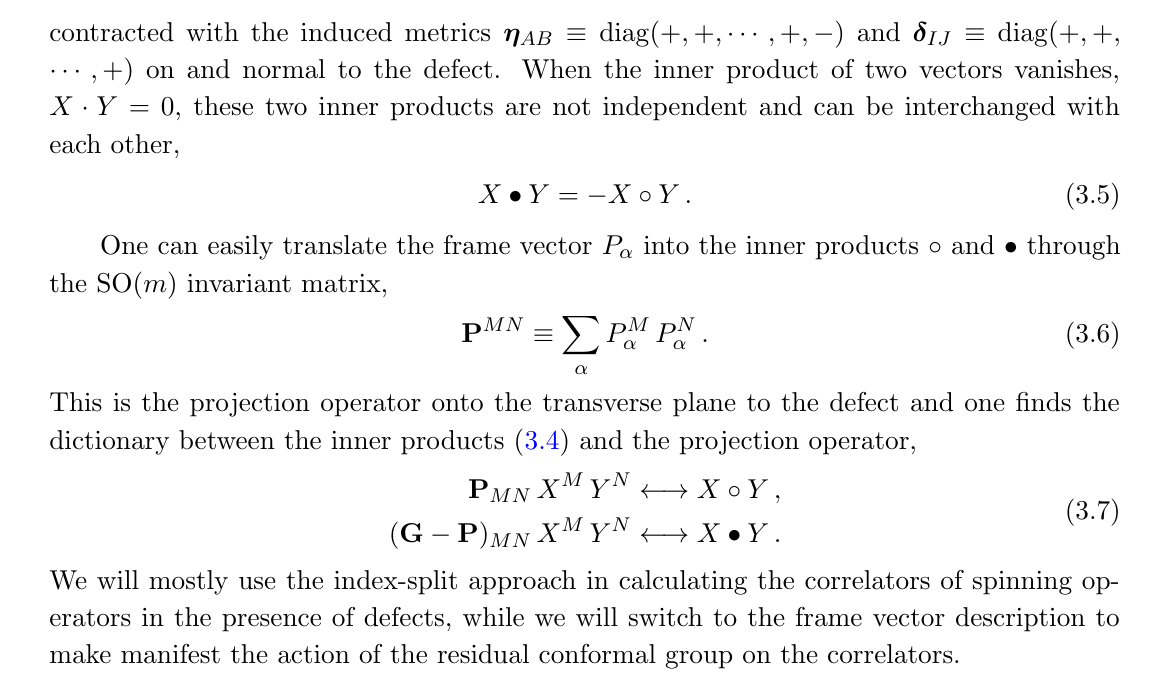
Figure 1 . A conformal defect is a hypersurface orthogonal to the frame vectors P (cid:11) . Defect local operators ^ O are supported on the worldvolume while bulk local operators O can be placed